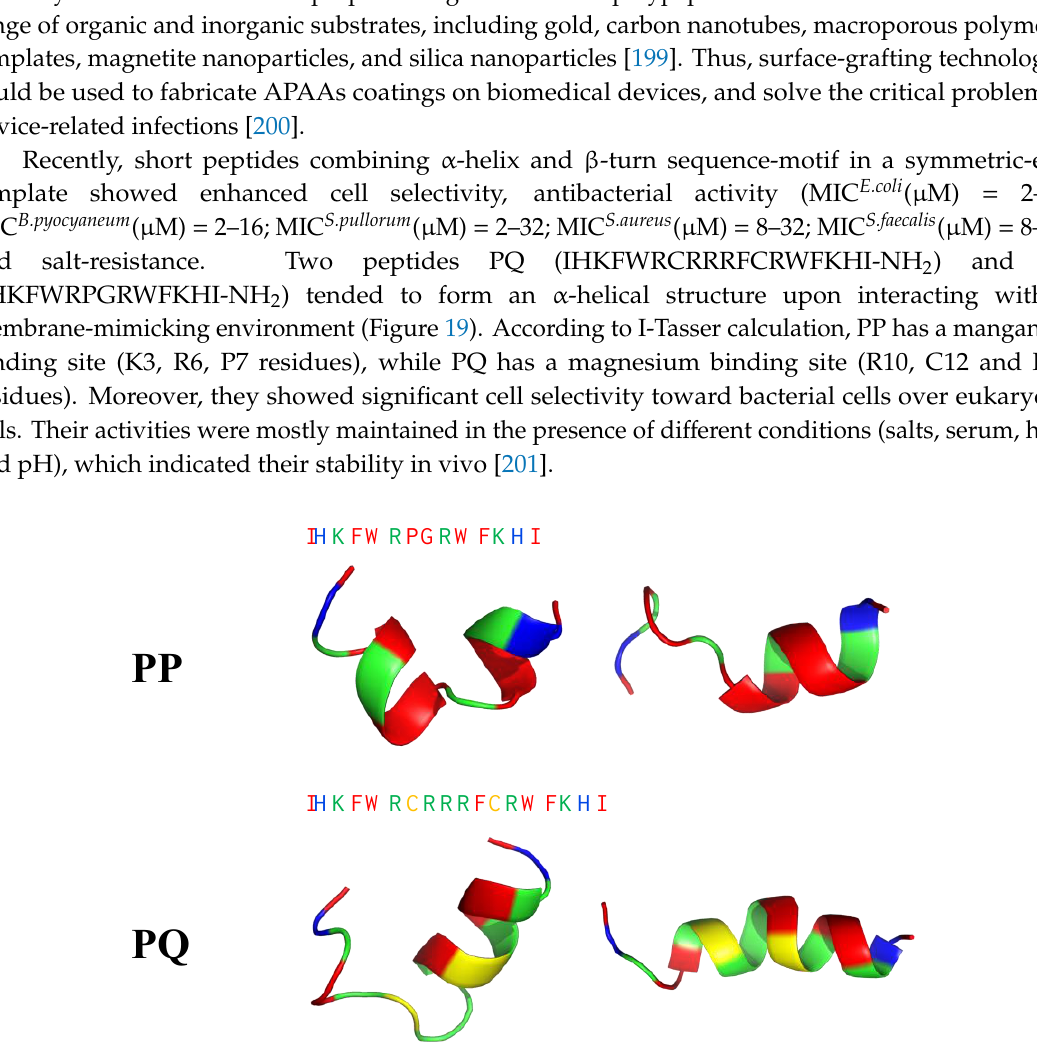
Figure 19. Two possible secondary structures of PP and PQ peptides calculated with I-Tasser. In blue: hydrophilic amino acids; in green: positively charged amino acids; in red: hydrophobic amino acids.